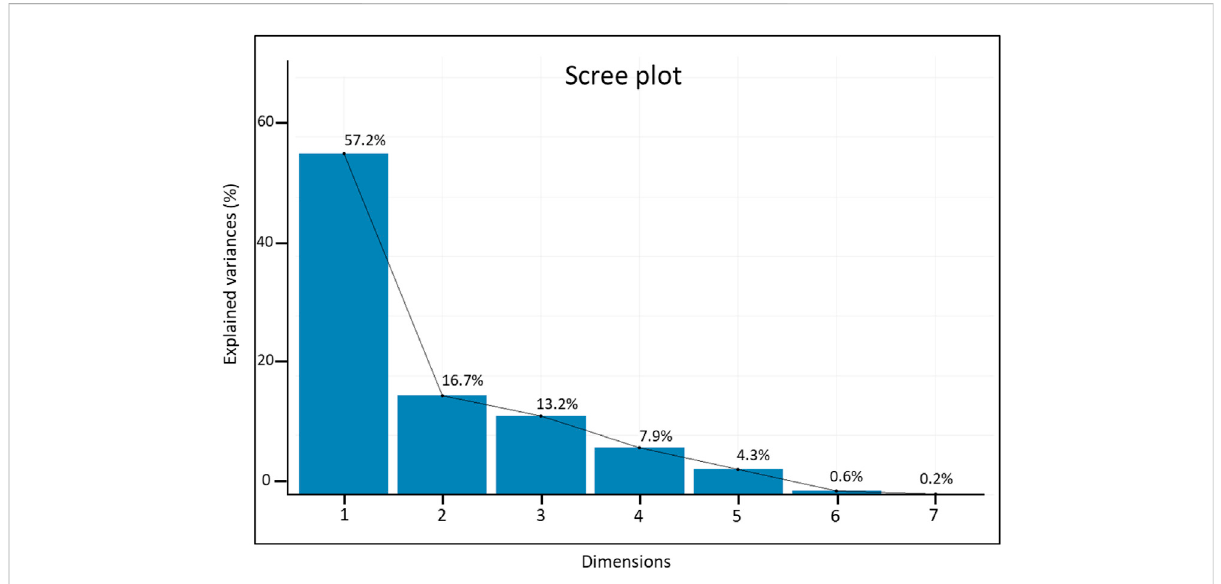
FIGURE 5 Scree plot showing the contributions of the fi rst seven principal